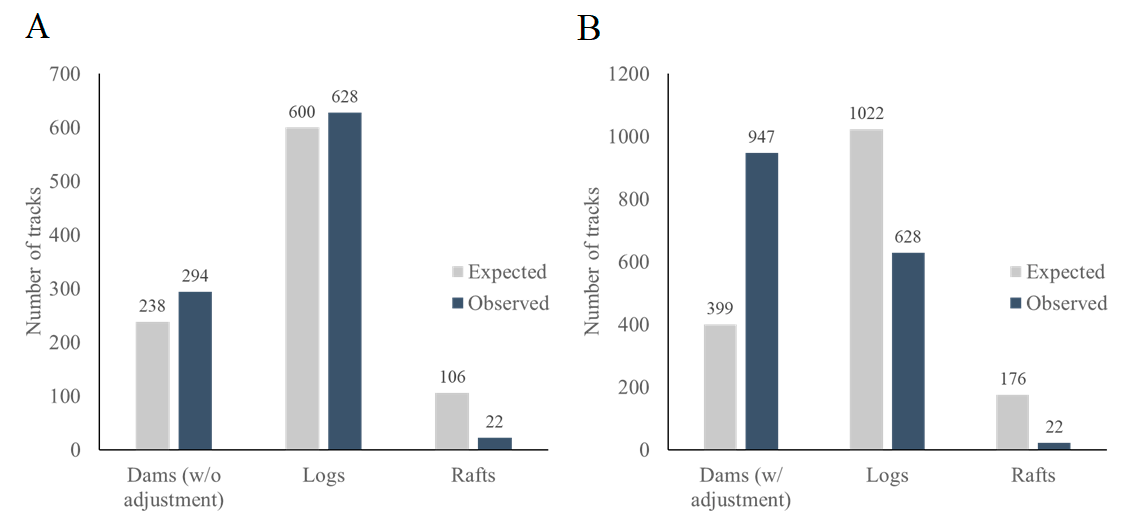
Figure 8. Comparison of mammalian activity among three categories of tracking tunnel locations (all taxa, points, and sites combined): ( A ) without adjustments (raw track counts); and ( B ) adjusted for the breadth of movement corridors available for animals travelling across the riverbed. The width of each dam was divided by the width of the trap (35 cm), and each obtained quotient was used as an individual coefficient by which the raw number of tracks on a particular dam was multiplied. The counts from logs and rafts remained raw.